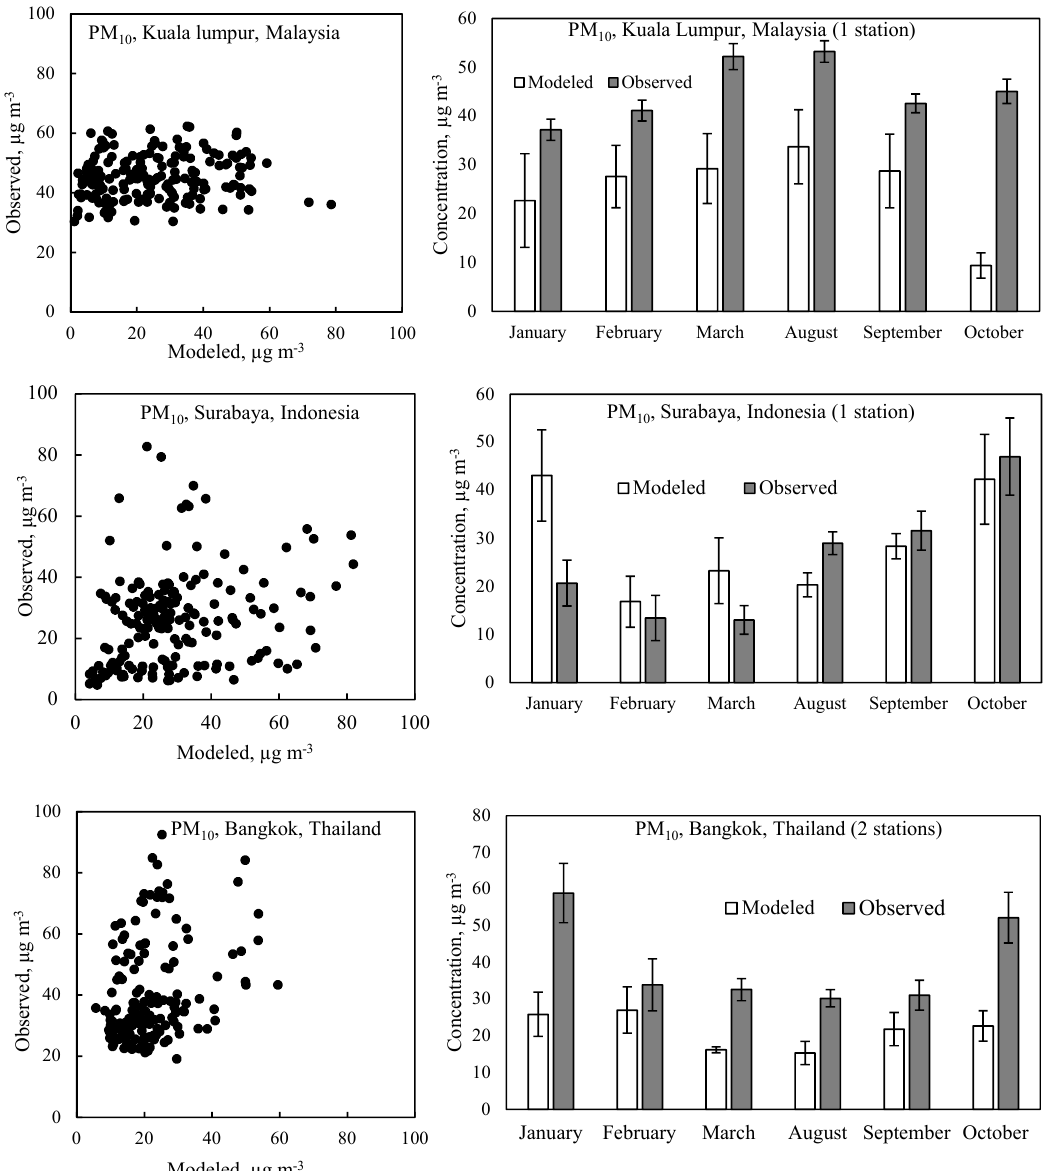
Figure 3. Comparison of modeled and observed 24h PM 10 in Kuala Lumpur, Malaysia (one station), Surabaya, Indonesia (one station), and Bangkok, Thailand (three stations). Note that the stations included in the comparison are those located within the